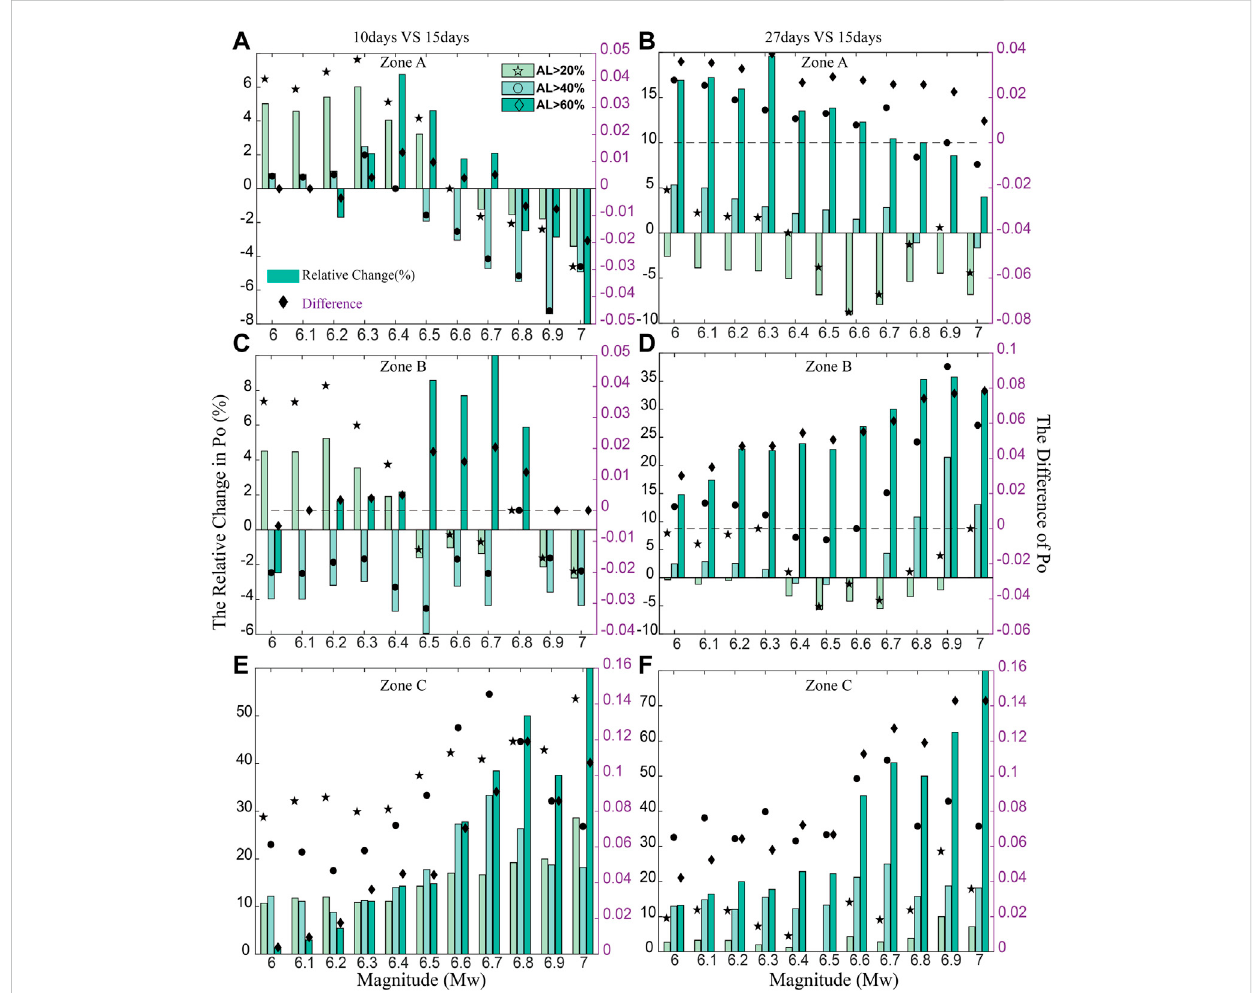
FIGURE 3 The differences and relative changes of seismo-ionospheric anomalies occurrence probabilities between the results of different sliding windows. (A, C, E) show the difference between the results of 10-day and 15-day sliding windows in Zone A, Zone B and Zone C, respectively. (B, D, F) show the difference between the results of 27-day and 15-day sliding windows in Zone A, Zone B and Zone C,